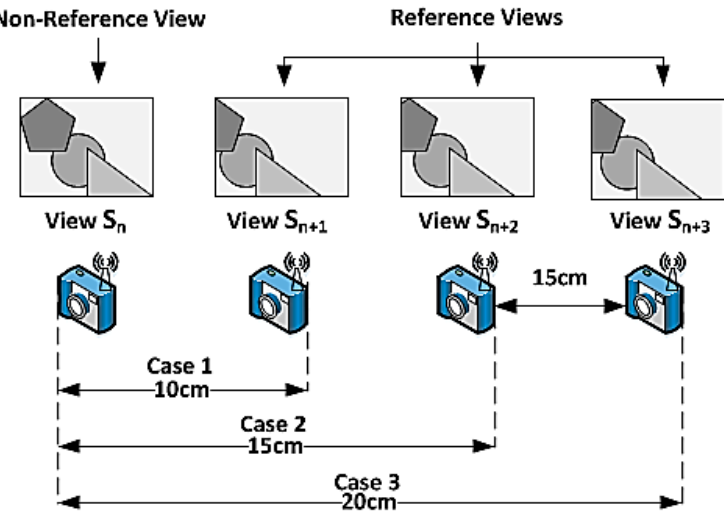
Figure 12 . Different separation setups . Figure 12. Di ff erent separation setups. Table 4. Sample images captured by the visual nodes. Table 4 . Sample images captured by the visual nodes Table 4 . Sample images captured by the visual nodes Table 4 . Sample images captured by the visual nodes Table 4 . Sample images captured by the visual nodes Table 4 . Sample images captured by the visual nodes Table 4 . Sample images captured by the visual nodes Table 4 . Sample images captured by the visual nodes Table 4 . Sample images captured by the visual nodes Table 4 . Sample images captured by the visual nodes Table 4 . Sample images captured by the visual nodes Table 4 . Sample images captured by the visual nodes Table 4 . Sample images captured by the visual nodes Non-Reference Image